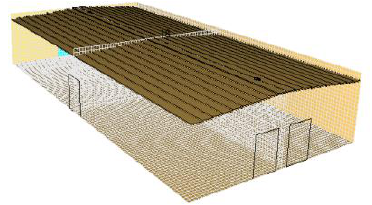
Figure 4. Fire Dynamics Simulator (FDS) Model.